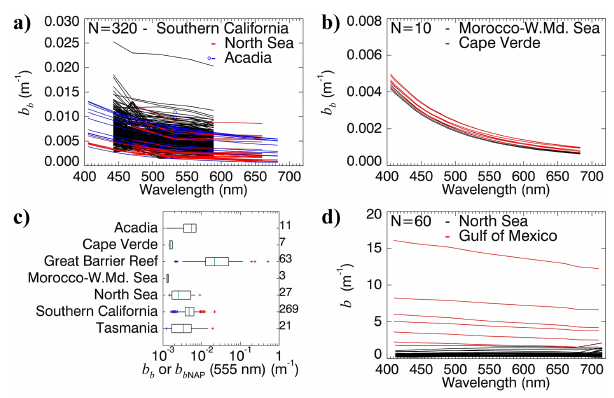
Figure 16. The spectra of (a) b (m − 1 ) measured in the Gulf of Mex- ico and North Sea sites and (b) b b (m − 1 ) measured in five Coast- Colour sites (note that the coefficients from the southern California were limited to the spectral range 442–589nm).